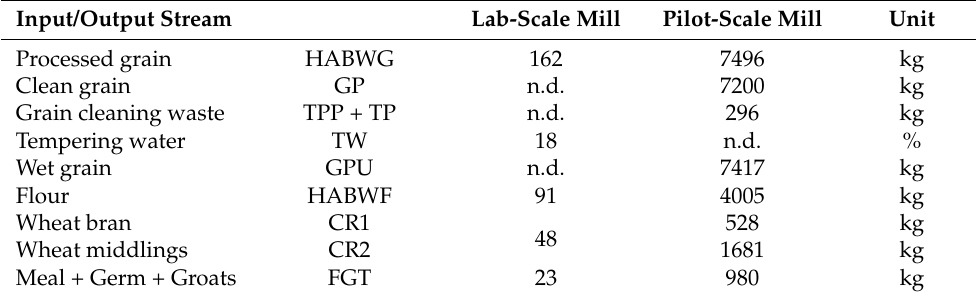
Table 2. Main results of a few grinding tests using high-amylose bread wheat grains, which